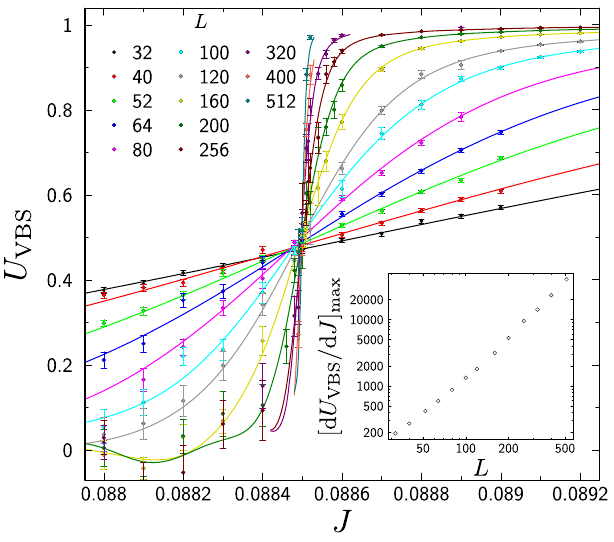
FIG. 11. U versus J for several system sizes ranging from VBS 32 to 512. Inset: Maximum value of d U